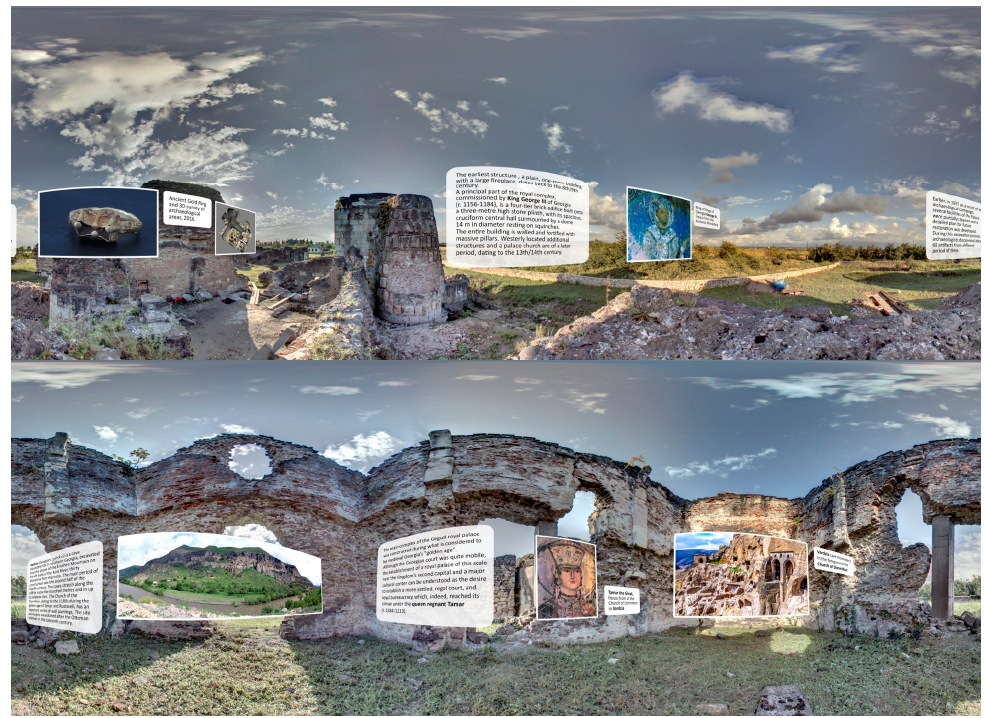
Figure 3. Information about the historical, cultural and geographic significance has been aggregated and displayed on the spherical photos by the use of Affinity software, which allows quickly editing the two-dimensional planar development of spherical